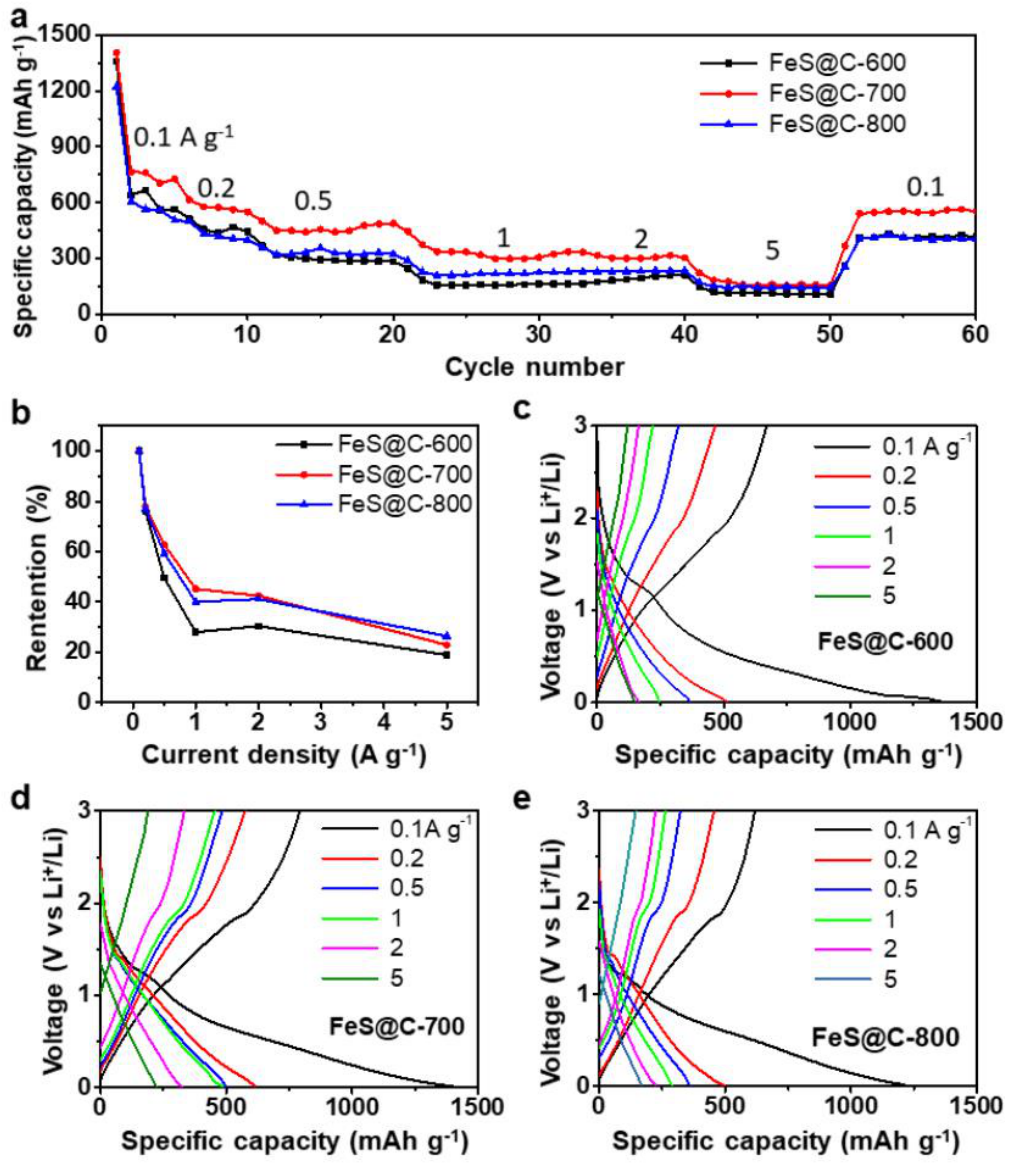
Figure 3. ( a ) Rate capability of the FeS@C electrodes at various current densities from 100 mA g − 1 to 5000 mA g − 1 . The mass loading of three electrodes is over 1.0 mg cm − 2 . ( b ) Retention of